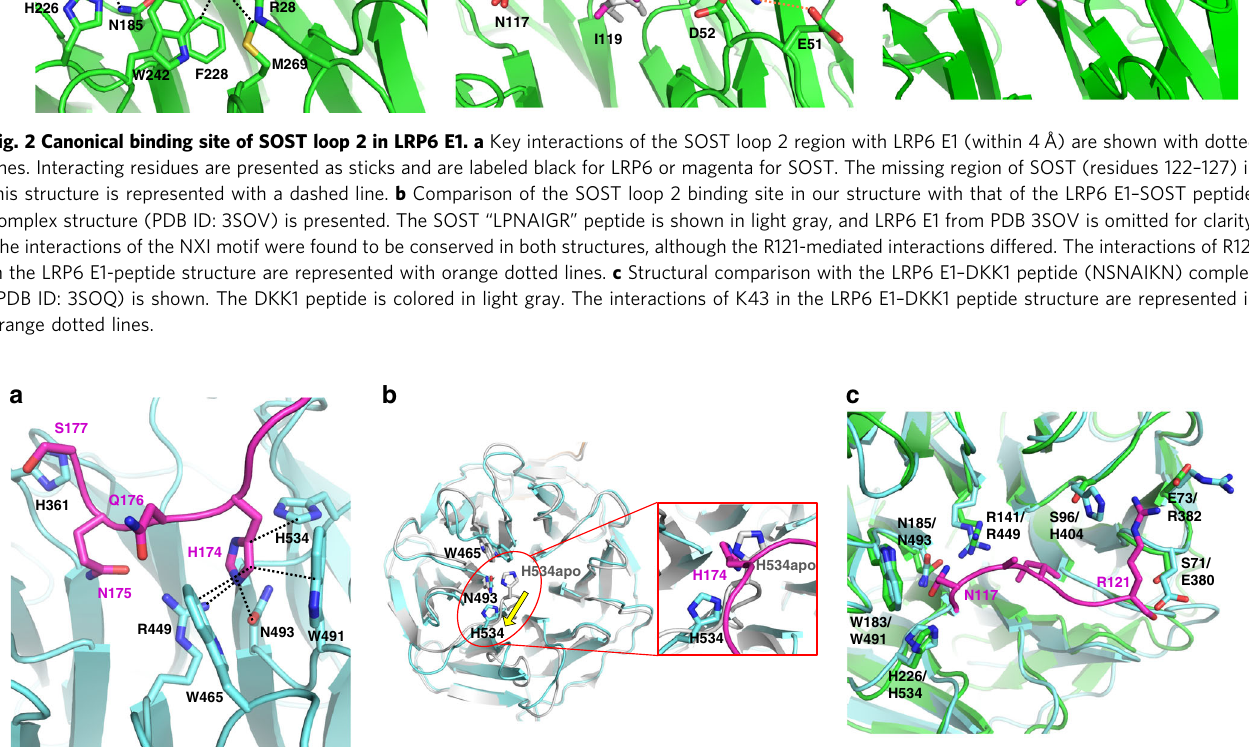
Fig. 3 Interaction of SOST C-tail with LRP6 E2. a The HNQS motif of the SOST C-terminus fi ts into the binding pocket of the LRP6 E2 β -propeller domain. Interactions of SOST H174 with LRP6 residues are shown with black dotted lines. b The ligand-free state of LRP6 E2 (PDB ID: 3S94; light gray) was aligned to LRP6 E2 (cyan) in our SOST-bound structure. For clarity, SOST was omitted from the overall alignment of LRP6 E2, on the left. Structural changes near W465 and H534 in LRP6 E2 upon SOST binding are shown. H534 of LRP6 moved from the concave center of the β -propeller domain by binding to SOST H174 (colored in magenta in an enlarged box on the right). c The structure of HNQS-bound LRP6 E2 (cyan) was aligned with the structure of loop 2-bound LRP6 E1 (green). The HNQS region is not shown for clarity. Loop 2-interacting residues in LRP6 E1 and corresponding residues in LRP6 E2 are represented as sticks and E2 residues are labeled after the E1